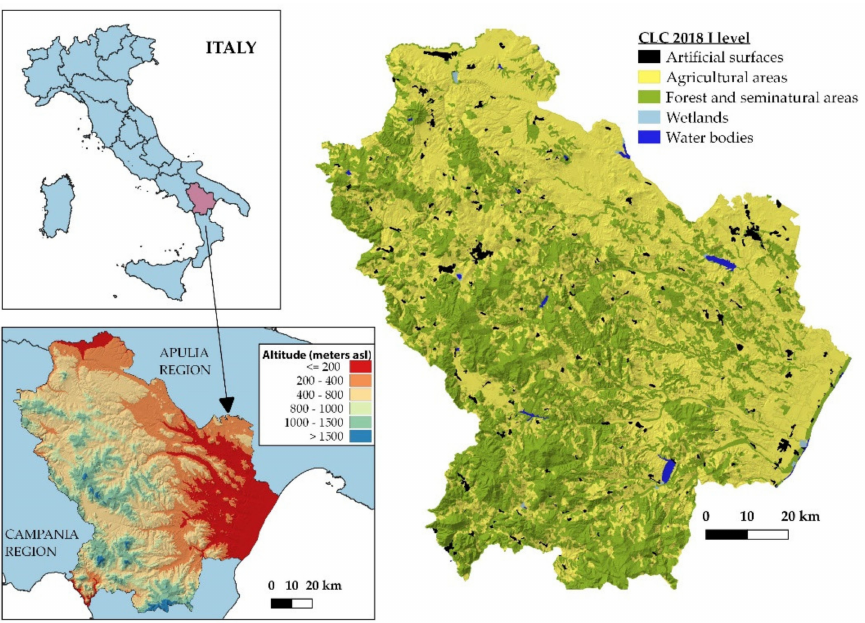
Figure 1. Location of the study area within Italy with maps showing altitude and land cover using CORINE Land Cover I Level 2018. Centroid: 40 ◦ 29 (cid:48) 51.9 (cid:48)(cid:48) N 16 ◦ 06 (cid:48) 10.6 (cid:48)(cid:48) E